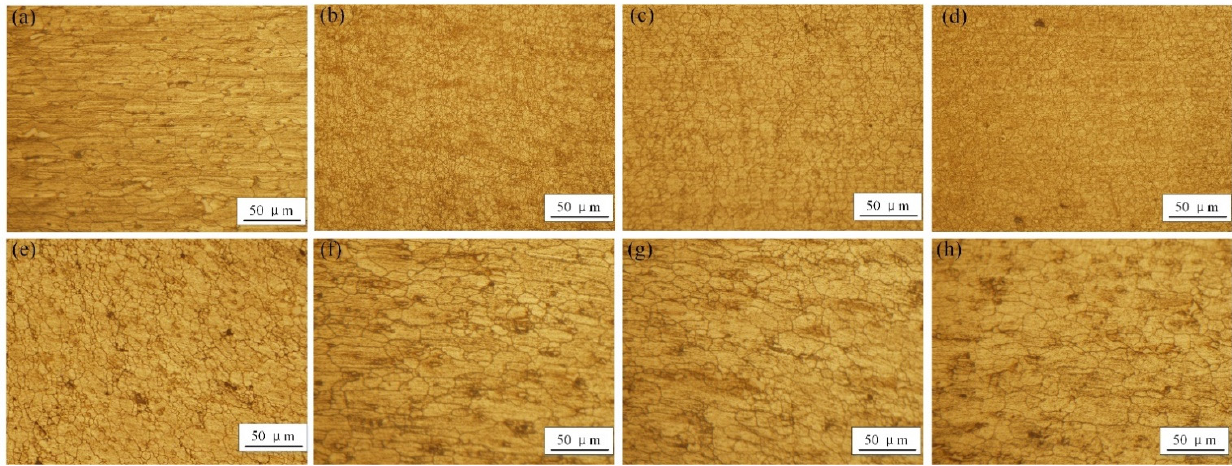
Figure 7. Typical microstructures at different welding speeds: ( a ) BM, ( b ) SZ at 110 mm/min, ( c ) SZ at 150 mm/min, ( d ) SZ at 190 mm/min, ( e ) TMAZ at 110 mm/min, ( f ) HAZ at 110 mm/min, ( g ) HAZ at 150 mm/min and ( h ) HAZ at 190 mm/min.